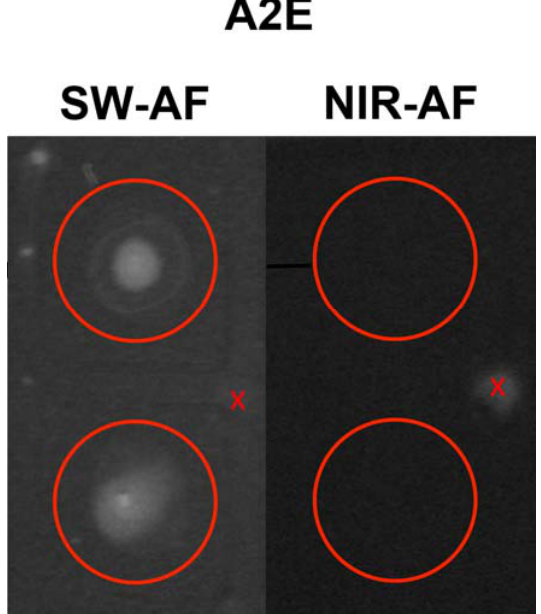
Figure 8. Synthesized A2E imaged with a confocal scanning laser ophthalmoscope (HRA2; Heidelberg Engineering, Heidelberg, Germany) using 488 nm (SW-AF) and 787 nm (NIR-AF) excitation. No signal was generated with the NIR